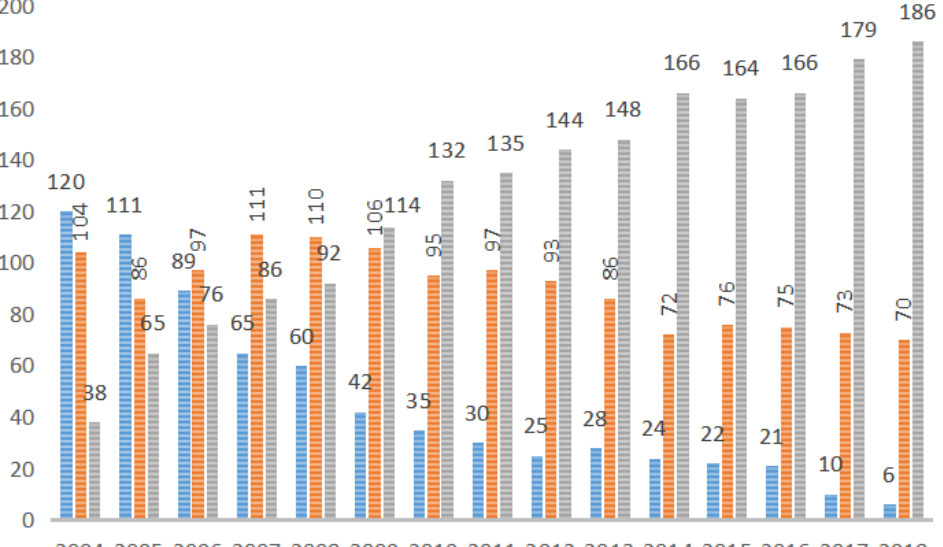
Figure 2. The number of cities in different environmental regulation zones from 2004 to 2018. Table 4. Threshold model results.